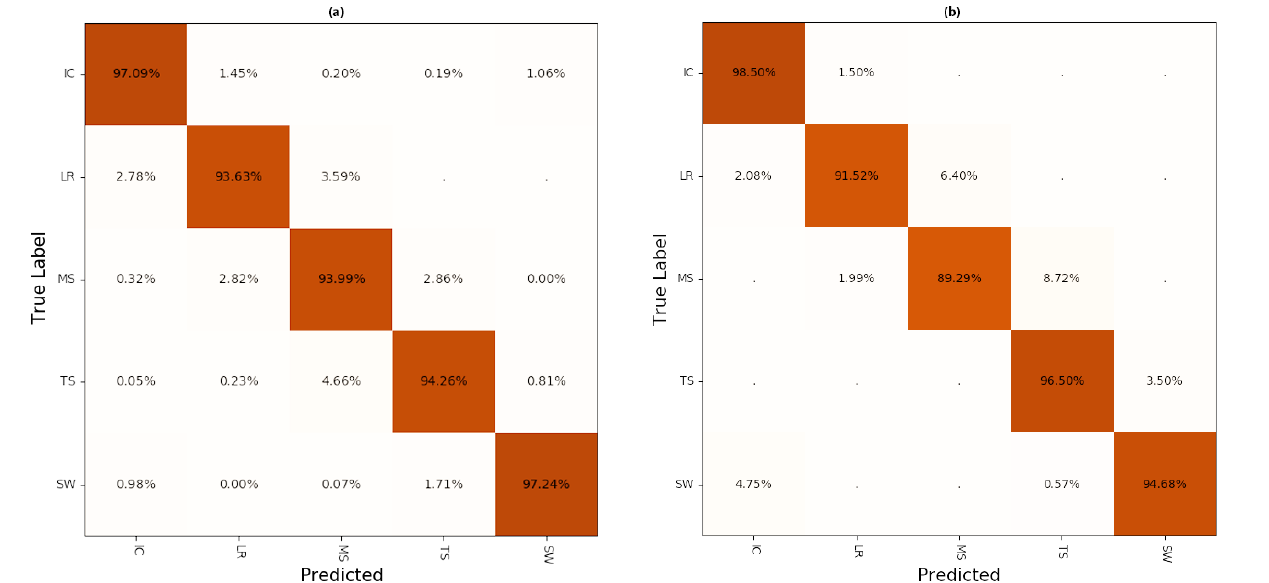
Figure 4. Confusion matrix of predictions applied to the test set ( a ), which consisted of 34% of the whole dataset and to one test person, who was not involved in the training process ( b ). On the main diagonal the correctly predicted labels can be